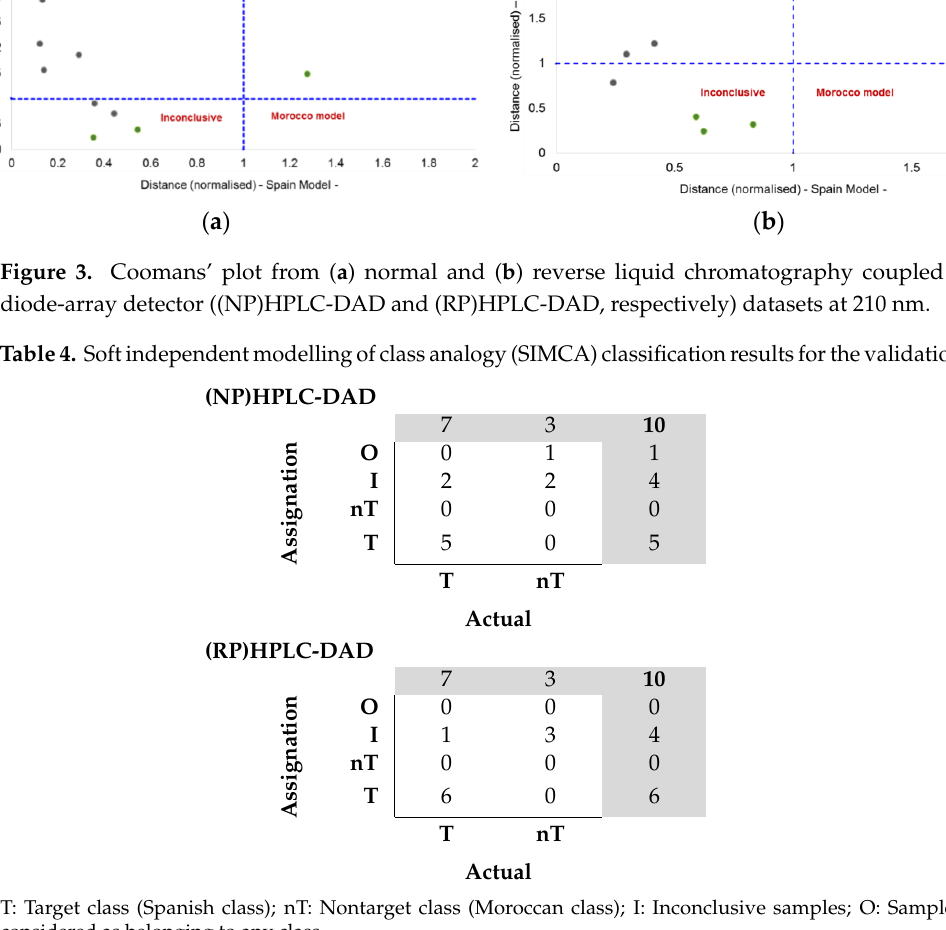
Figure 2. PCA scores obtained from the fingerprint data of the 35 margarine samples: PC1–PC2 plane of the chromatogram acquired at 210 nm: ( a ) In reverse phase; ( b ) In normal phase; and acquired at 254 nm: ( c ) In reverse phase; ( d ) In normal phase.